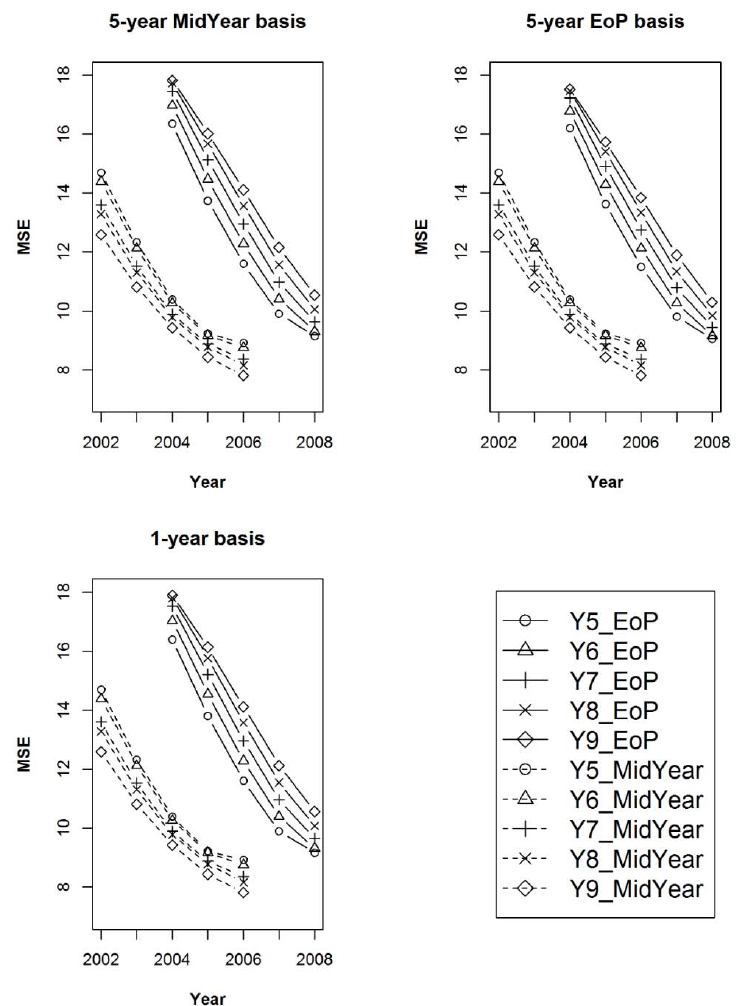
Figure 7. The mean of the Mean Squared Errors ( MSE ) for the MidYear annual mean (for years 2002 through 2006) and the EoP annual mean Estimators (for years 2004–2008) after 100 iterations of samples of size 1000 within the 125 populations, for sample observation lengths of five, six, seven, eight, and nine years, or deviations (from 50 dy ) of 0, 10, 20, 30, and 40, respectively. As in Figure 6, each graph is relative to a unique estimand: ( a ) Estimand 1 with a five ‐ year MidYear basis; ( b ) Estimand 2 with a five ‐ year EoP basis; ( c ) Estimand 3 with a one ‐ year basis.